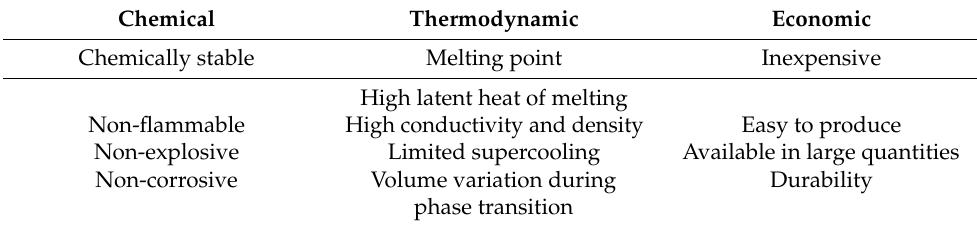
Table 1. PCM selection criteria